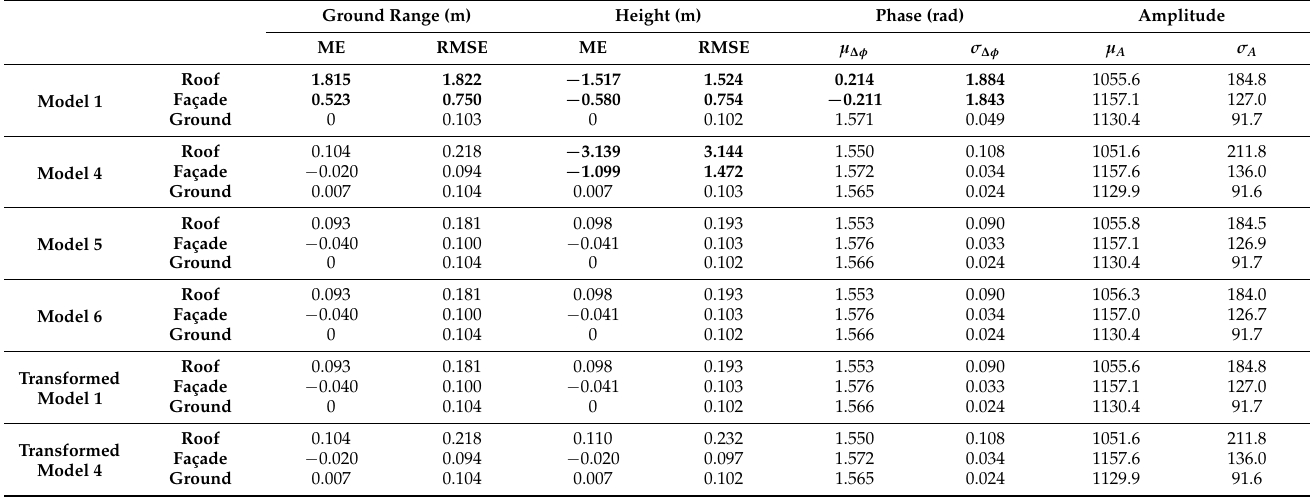
Figure 17. The reconstruction obtained under model 4 (the approximate form of the planar wavefront model) after transformation: ( a ) reconstruction with colors denoted as height, ( b ) reconstruction with colors denoted as amplitude, ( c ) reconstruction with colors denoted as phase, ( d ) the off-nadir angle of the reconstruction, ( e ) the error of the ground range and height, ( f ) the error of the phase. To give a comprehensive summary of this subsection, Table 3 shows the quantitative analysis of inversion results using simulated data by different models. In this paper, bold numbers in all tables indicate unqualified results. From this table, the conclusions are drawn that the ground range, height and phase of inversion results under model 1 are inaccurate, and that the height of inversion results under model 4 is inaccurate. After using transformation methods mentioned in Section 2.4, the inversion results under transformed model 1 and transformed model 4 are accurate. Table 3. The quantitative analysis of inversion results using simulated data in experiment 1.